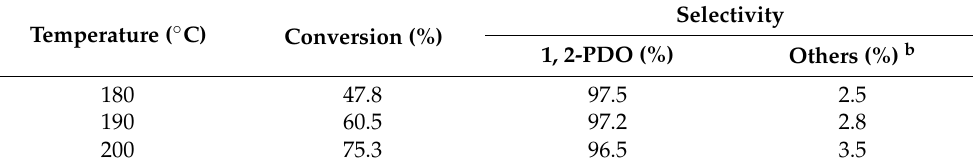
Table 5 . Hydrogenolysis of glycerol and composition on recycled CuMgFe-4LDO a .